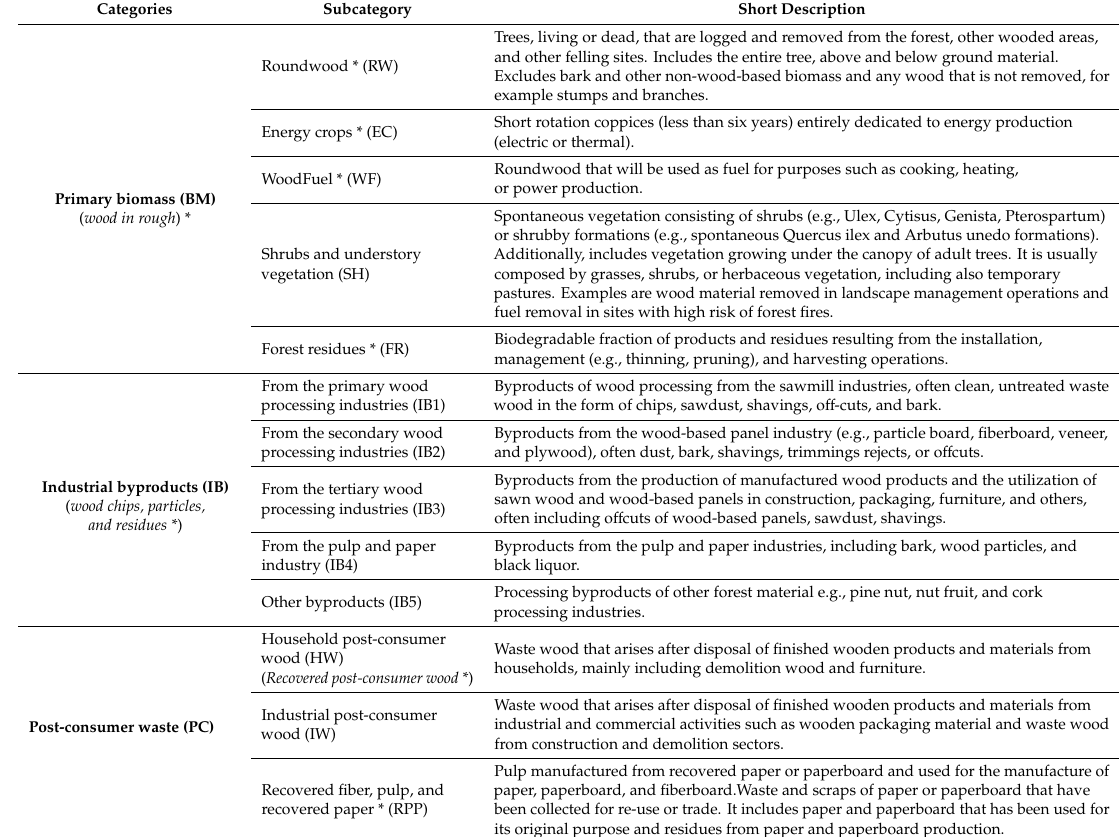
Table 1. Categorization of the wood-based biomass sources (definitions adapted for Eurostat-Joint Forest Sector Questionnaire (JFSQ) are marked with